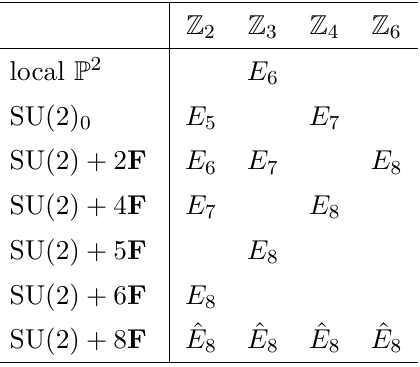
Table 4 . Flavor symmetries after the Z 2 , 3 , 4 , 6 quotient of 5d rank-1 theories. Here, E 5 = D 5 .